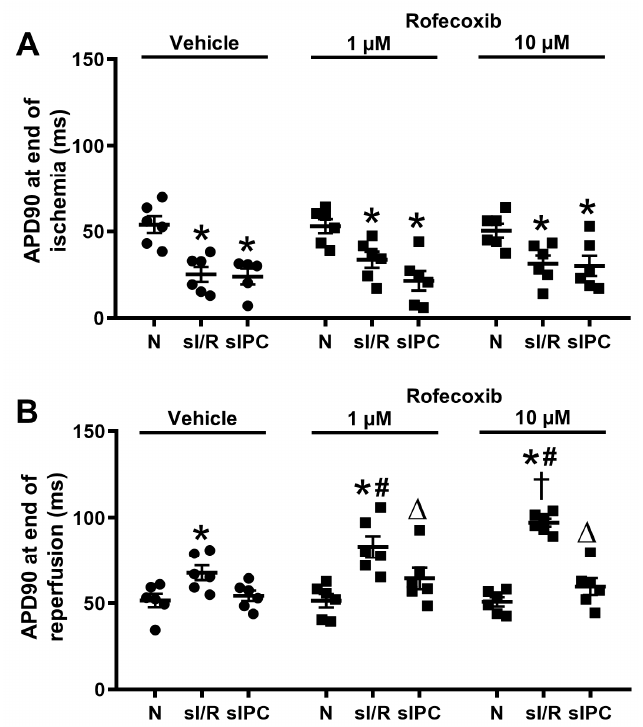
Figure 8. ( A ) Action potential duration at 90% repolarization (APD 90 ) decreased by the end of 30 min. simulated ischemia in the simulated ischemia/reperfusion groups (sI/R) and simulated ischemic preconditioning groups (sIPC) as compared to the normoxia (N) group. ( B ) Rofecoxib increased the APD 90 in adult rat isolated papillary muscles at the end of reperfusion and this effect was reversed by sIPC (* p < 0.05 vs. corresponding normoxia group, # p < 0.05 vs. sI/R + vehicle,† p < 0.05 vs. sI/R + 1 µM rofecoxib, ∆ p < 0.05 vs. corresponding sI/R group, n = 5–6).